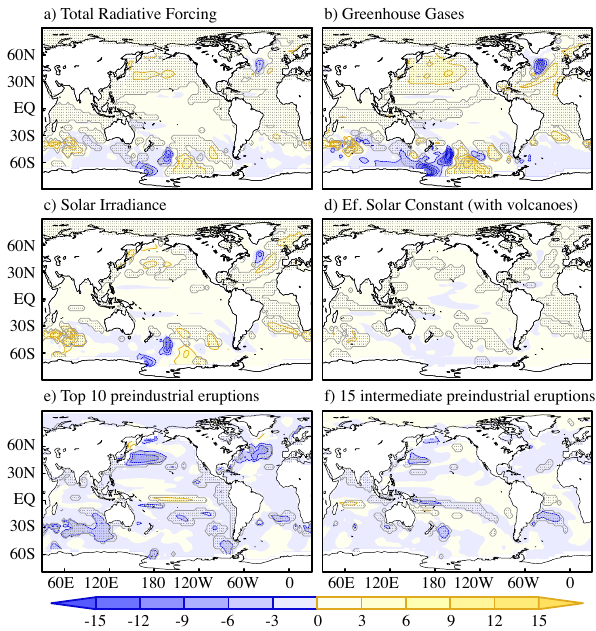
Fig. 7. (a–d) Regression patterns in FOR2 between the OHC700 anomalies (in 10 8 Jm − 2 ) and the standardised series of the total ra- diative forcing, the equivalent forcing of GHGs, the solar irradiance and the effective solar constant, i.e. solar irradiance+radiative ef- fect of volcanic aerosols, respectively. Significance is addressed as in Fig. 6. (e–f) Composite of the OHC700 differences between the 5yr following and 5yr preceding the top 10 and the next 15 largest preindustrial eruptions. Significance is established at the 0.05 level through a Monte Carlo test based on 1000 random selections in CTRL.